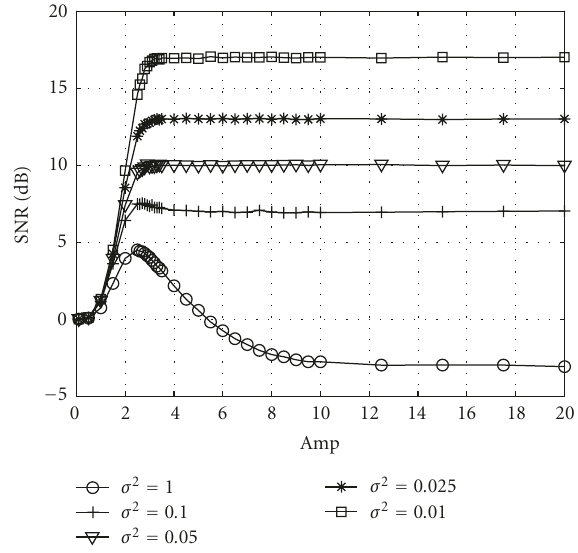
Figure 6: SNR versus Amp for various GIR values (rate = 1 . 0, A = 0 . 1, σ 2 = 0 . 05).